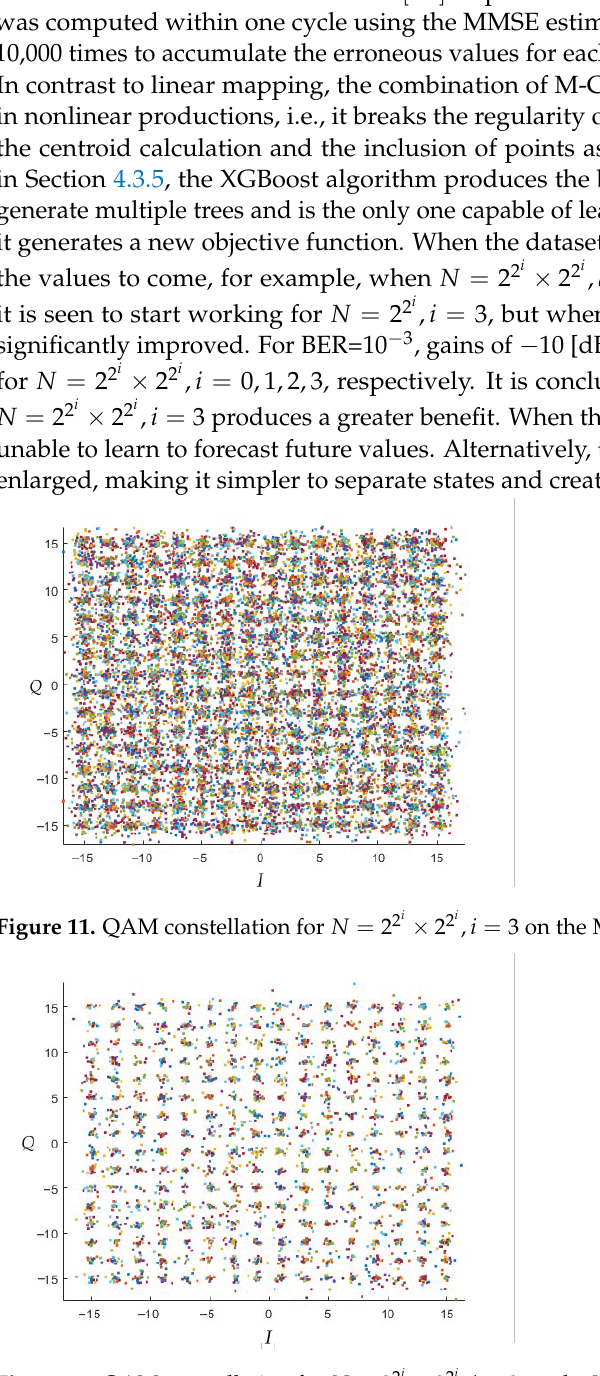
Figure 12. QAM constellation for N = 2 2 i × 2 2 i , i = 3 on the MIMO channel, SNR = 30 [ dB ]